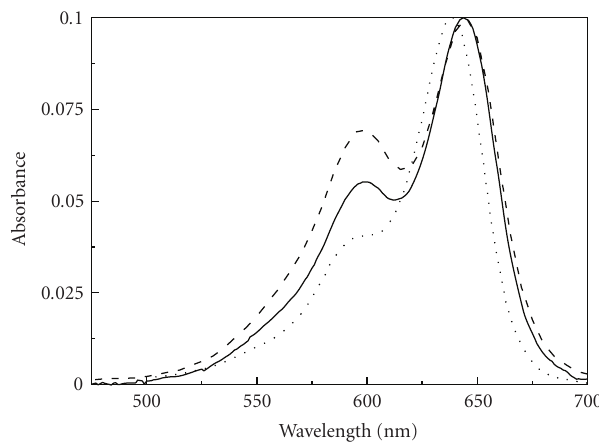
Figure 7: Absorption spectra measured from PAH-Cy5 C with label degrees 1 :490 (solid line), 1:320 (dashed line), and the free dye Cy5 (dotted